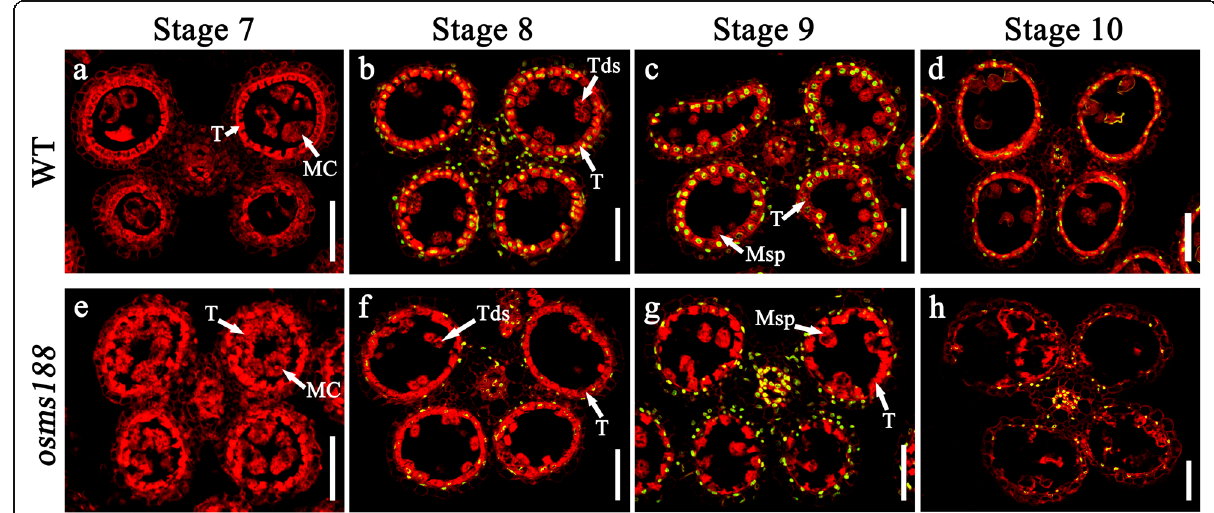
Fig. 3 TUNEL analysis in the anthers of WT and osms188 . The TUNEL signals are indicated with green fluorescence. The red fluorescence indicates nuclei stained with propidium iodide. At stage 7, no TUNEL signals were detected in the anthers of the WT ( a ) or osms188 ( e ). The TUNEL signals of the WT were normal at stage 8 ( b ), stage 9 ( c ) and stage 10 ( d ). Weak TUNEL signals were detected at stage 8 ( f ), stage 9 ( g ) and stage 10 ( h ) of the osms188 anthers. Bars = 50 μ m. MC, meiotic cell; T, tapetum; Tds, tetrads; Msp, microspore